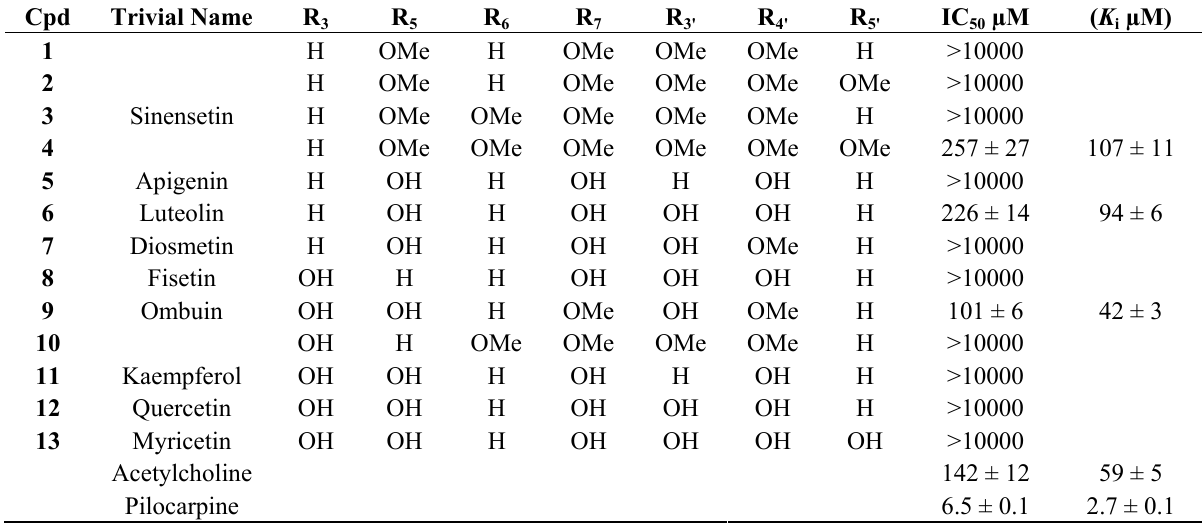
mAChR binding data of compounds 1 – 13 and standard 1